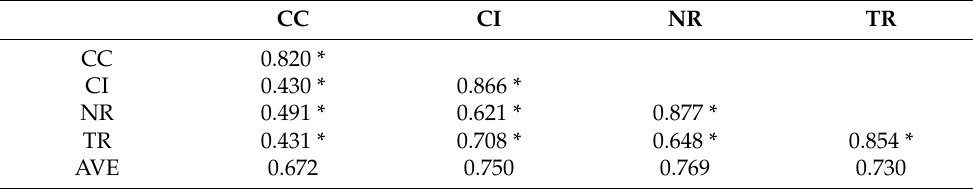
Table 4. Correlations and descriptive statistics of construct